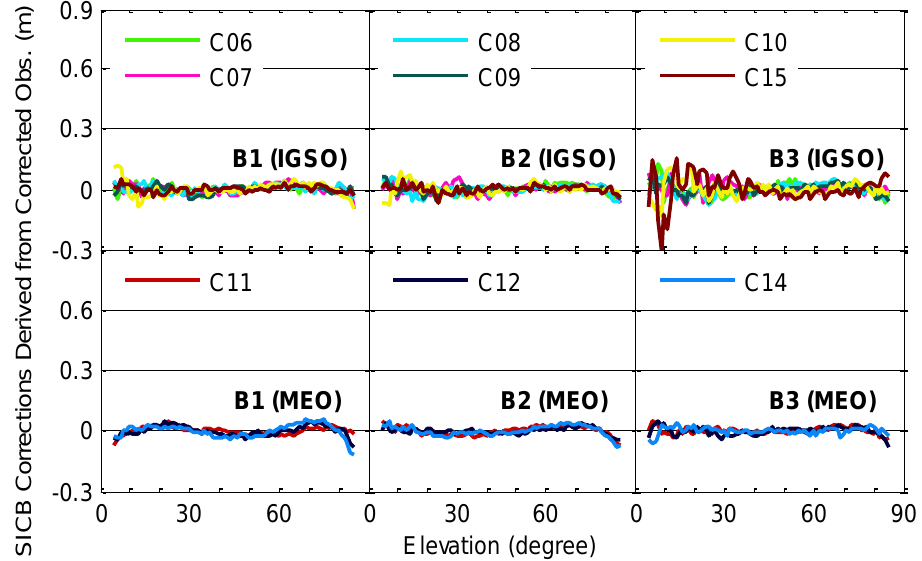
Figure 14. Reconstructed SICB correction model as a function of elevations on B1, B2 and B3 frequencies for each BDS-2 MEO and IGSO satellite using the code observations corrected by the previously established SICB correction model.